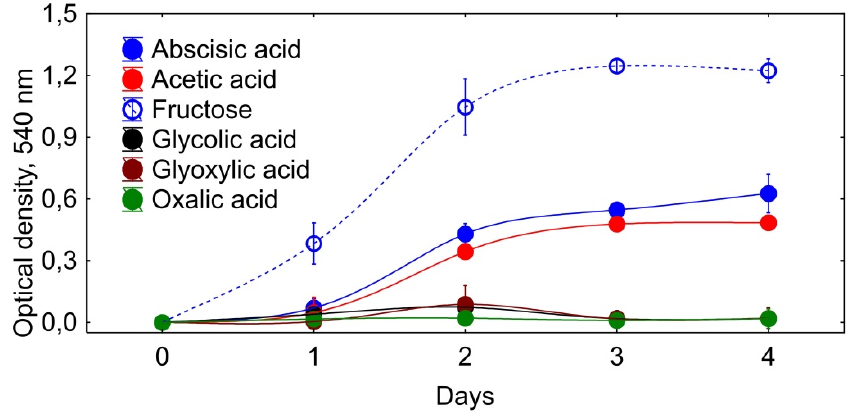
Figure 7. Growth of Rhodococcus sp. P1Y in a liquid mineral salt medium supplemented with different compounds as a sole carbon source. Carbon sources are shown in the figure. Vertical bars indicate confidence intervals ( n = 3; p <